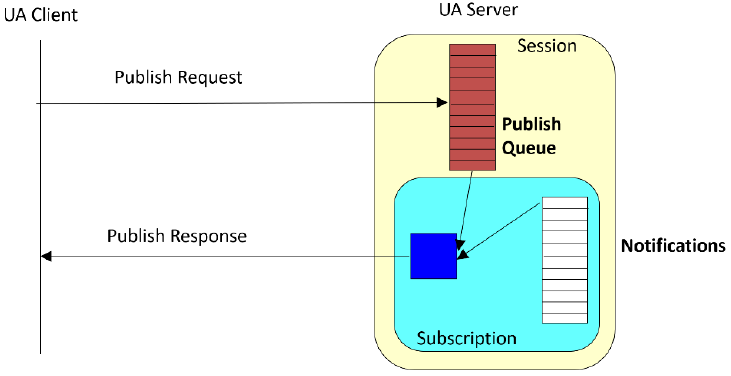
Figure 2. Subscription ‐ based communication in OPC UA.